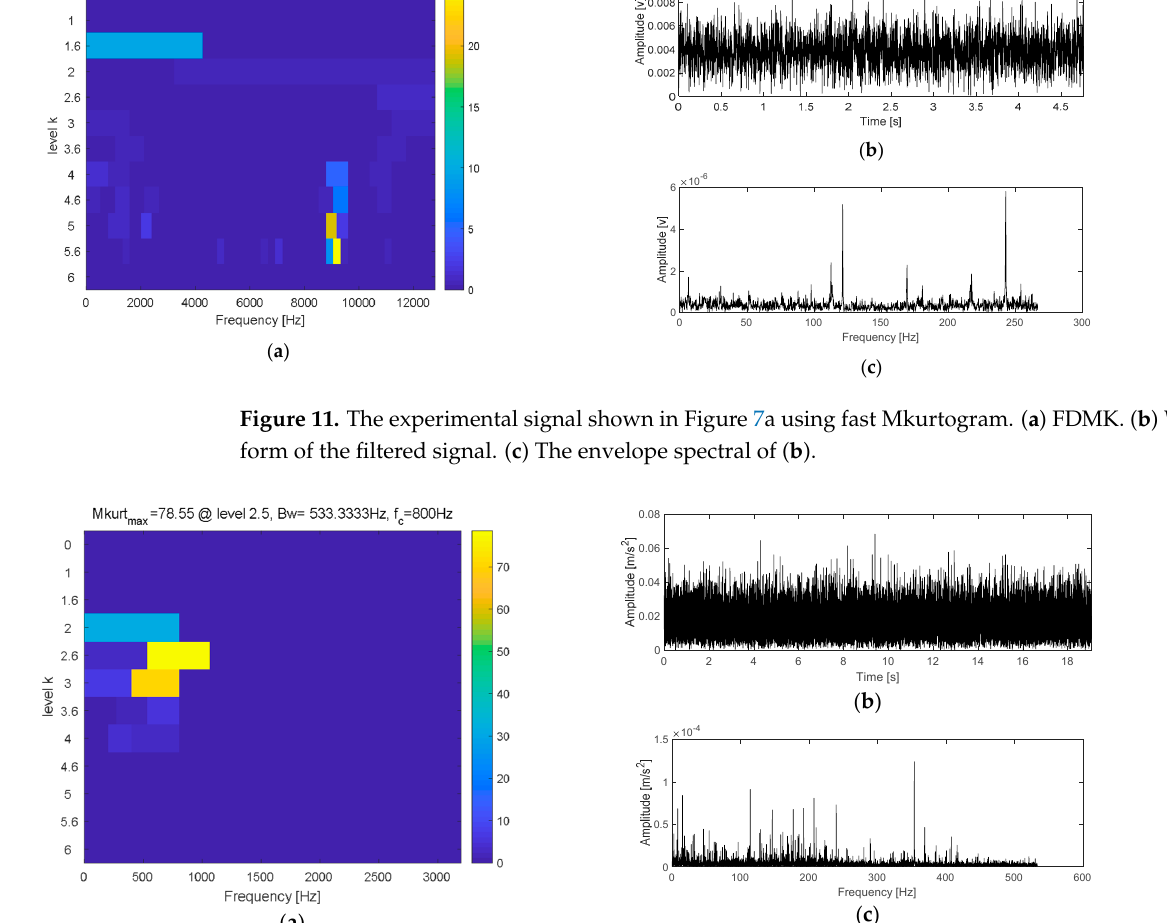
Figure 12. The engineering signal shown in Figure 9 using fast Mkurtogram. ( a ) FDMK. ( b ) Waveform of the filtered signal. ( c ) The envelope spectral of ( b ).